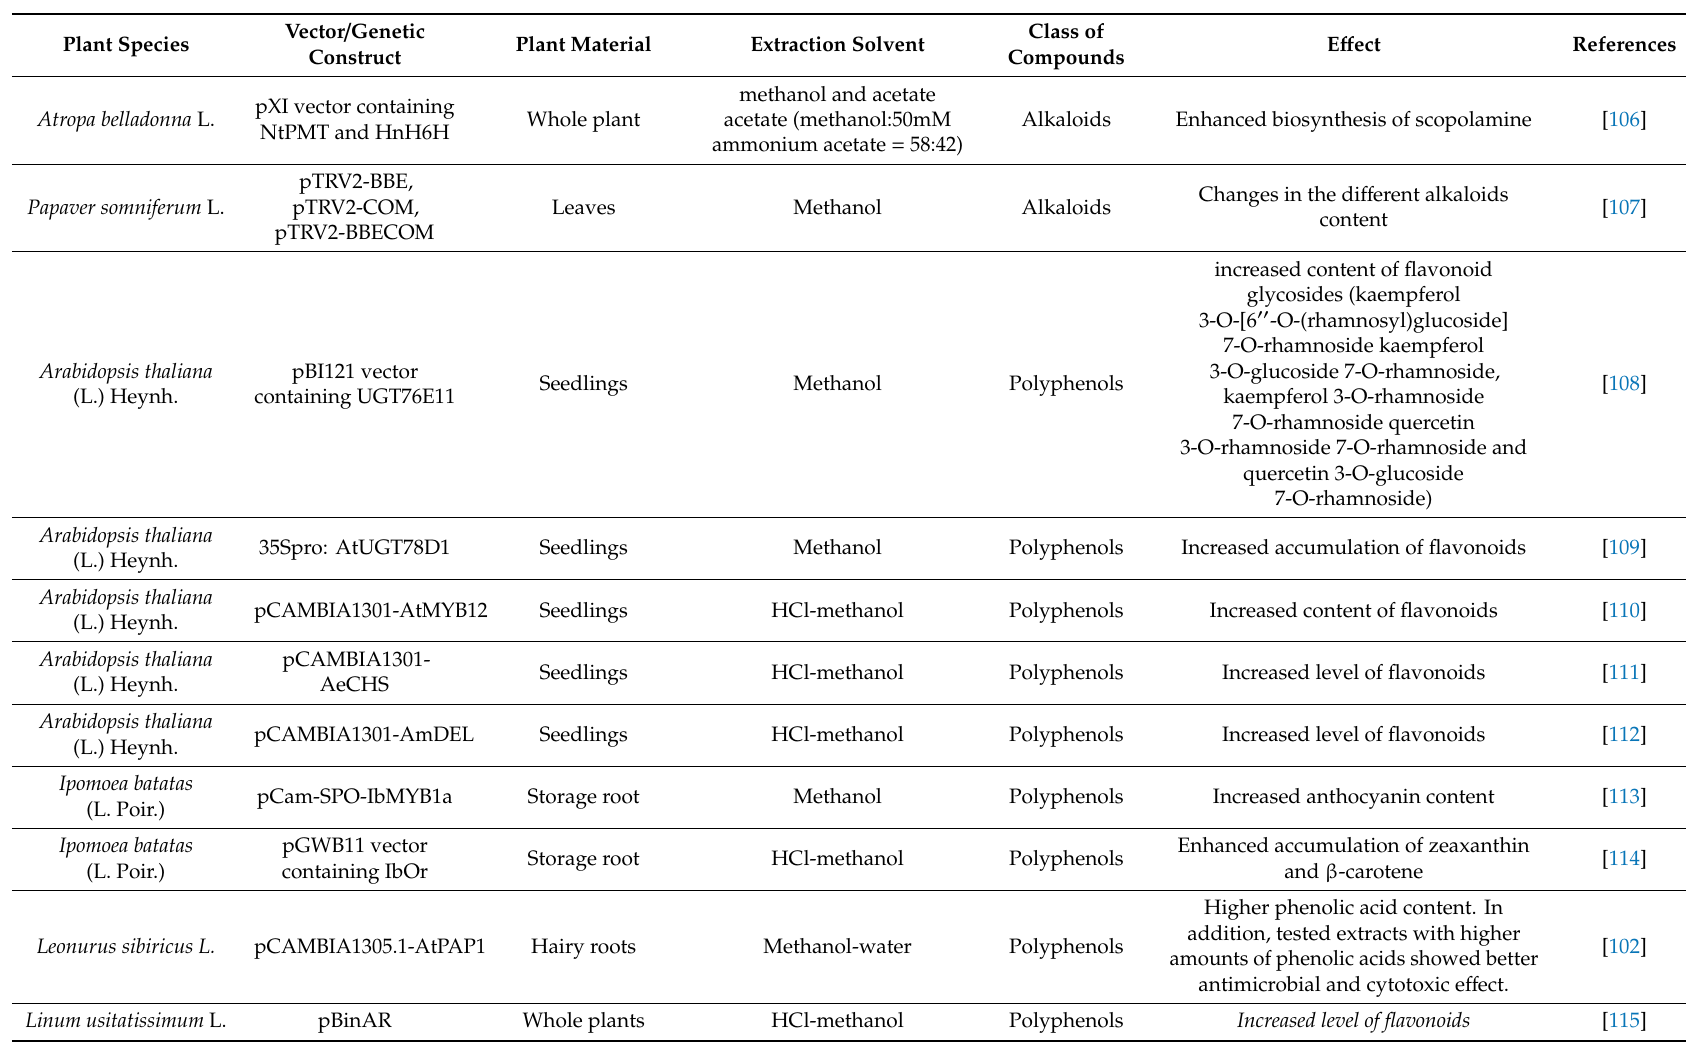
Table 1. Secondary metabolites derived from genetically-modified plant in vitro cultures with their biological